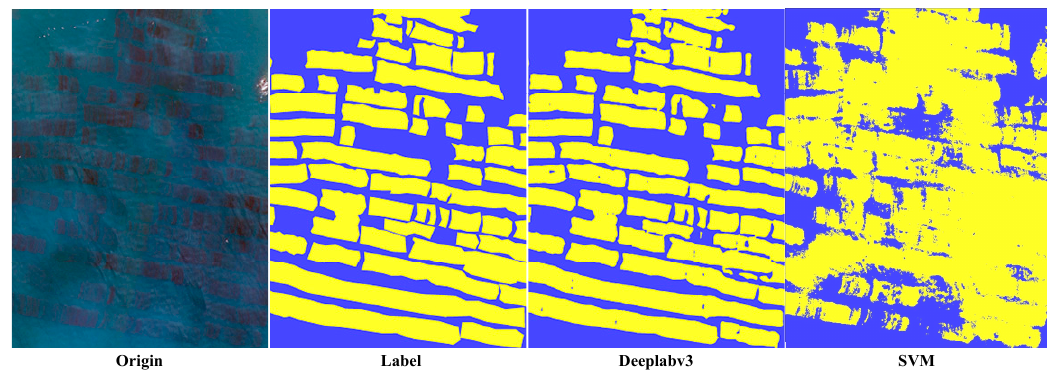
Figure 9. Comparison of classification accuracy between Deeplabv3 and SVM.